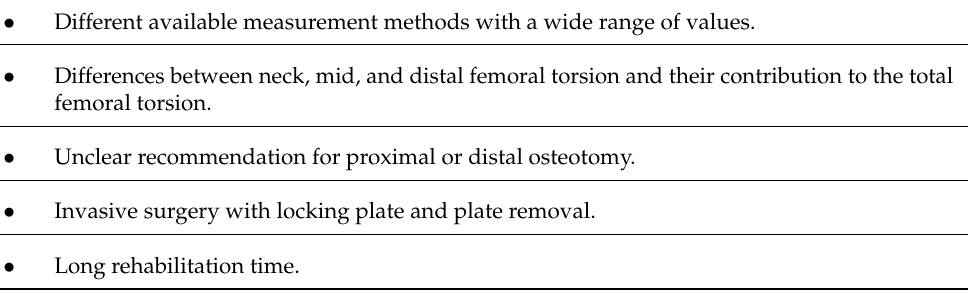
Table 3. Concerns about rotational osteotomies.